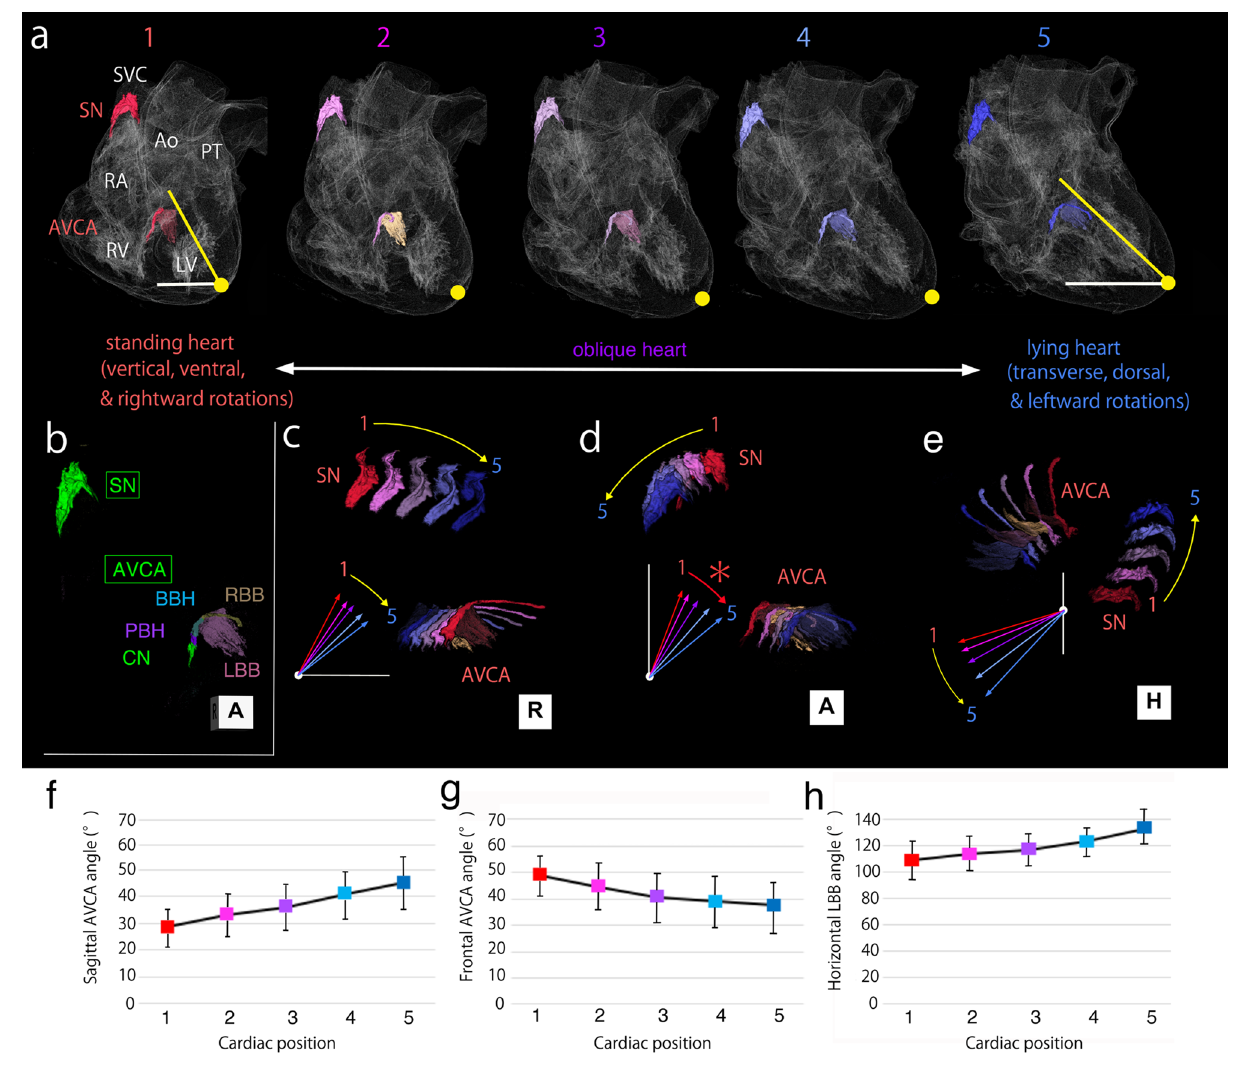
Figure 4. CT imaging-based simulation of the CCS arrangement by gradual stepwise rotations of the heart with standard CCS arrangement from the standing to lying position. The warm to cold colored CCS commonly represent the typical CCSs in the standing (1) to lying (5) hearts, respectively. The upper ( a ) and middle ( b ) rows show the gradual 3D transformation of the CCS within the heart and the CCS itself in the frontal view, respectively. The gradual changes of the superimposed CCS view are shown from the right lateral ( c ), frontal ( d ), and superior ( e ) aspects in the lower row. The graphs also show the changes in the simulation of the 2D projection angles of the CCS in the sagittal ( f ), frontal ( g ), and horizontal ( h ) rotations. As indicated in Fig. 3, the CCS and heart rotations are indicated by yellow rotating arrows when they are in the same rotating direction and by red rotating arrows when rotating in opposite directions. These findings show that the actual and theoretical simulation findings are consistent. Only the frontal cardiac and CCS rotations did not correlate, as shown in the 2D projection findings; however, the stepwise 3D CCS transformation was recognized with cardiac rotation from the standing to lying position. Ao aorta, AVCA atrioventricular conduction axis, PT pulmonary trunk, RA right atrium, RV right ventricle, SN sinus node, SVC superior vena